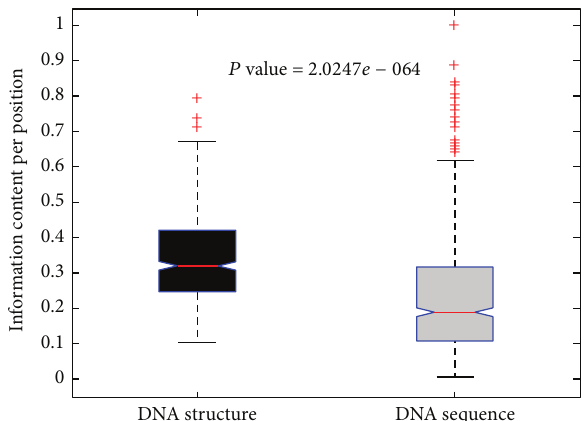
Figure 3: Information content per position in structure versus